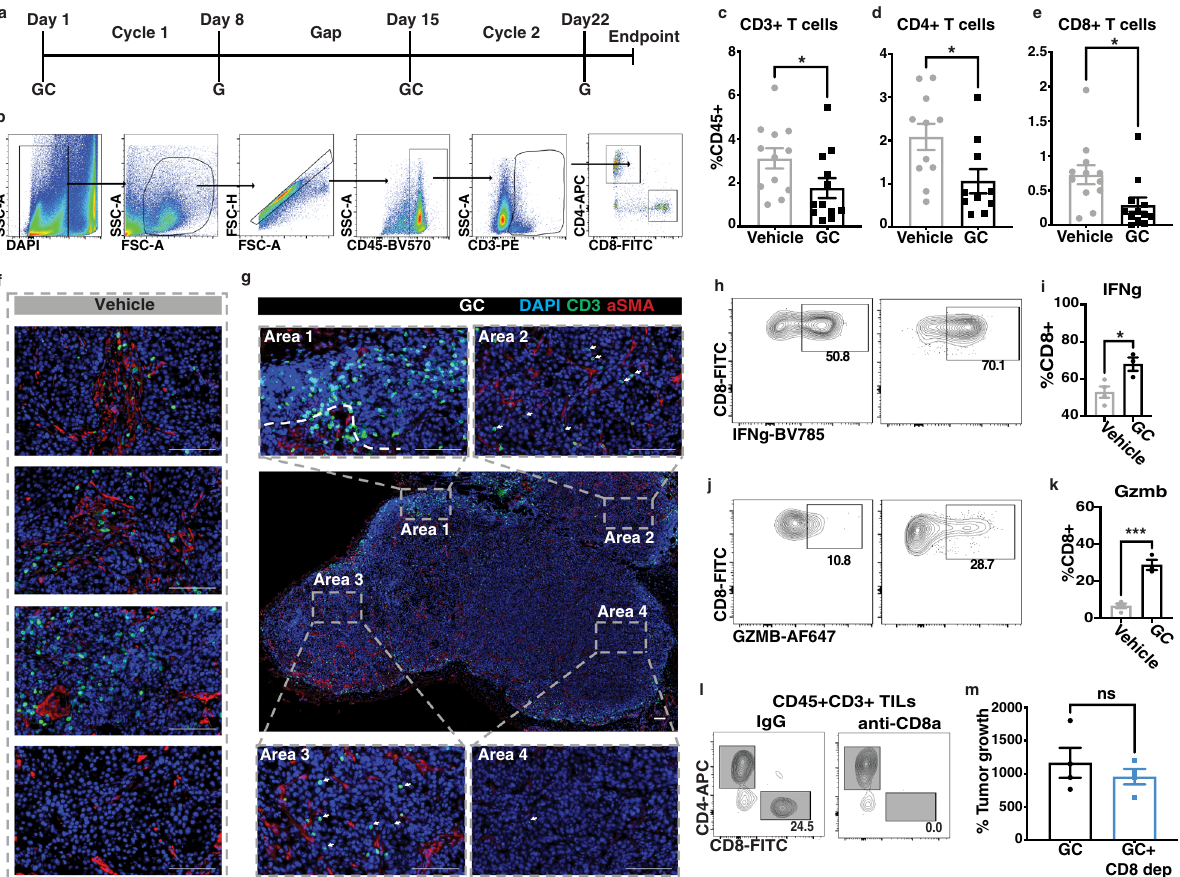
Fig. 2 CD8 + T cells are not tumoricidal despite expressing granzyme B and IFN γ . a Schematic representation of chemotherapy treatment cycles. b Flow cytometry gating strategy for T cells from dissociated G69-tumor tissues. c – e Quanti fi cation of CD3 + T cells and their subpopulations of CD4 + and CD8 + T cells from dissociated G69-tumor tissues treated with vehicle ( n = 12 biologically independent samples) or GC ( n = 11 biologically independent samples) for two cycles. Data are presented as mean values ± SEM. (Two-tailed, unpaired t -test; p = 0.048, p = 0.023, and p = 0.018 respectively). f , g Immuno fl uorescence analysis of CD3 + T-cell in fi ltration in vehicle and GC-treated G69 tumors. Selected ROIs ( g , 1 – 4) are representative areas that depict CD3 + T-cell localization in the tumor periphery and decreased CD3 + T-cell in fi ltration in the tumor (Scale bar: 100 μ m; Images representative of n